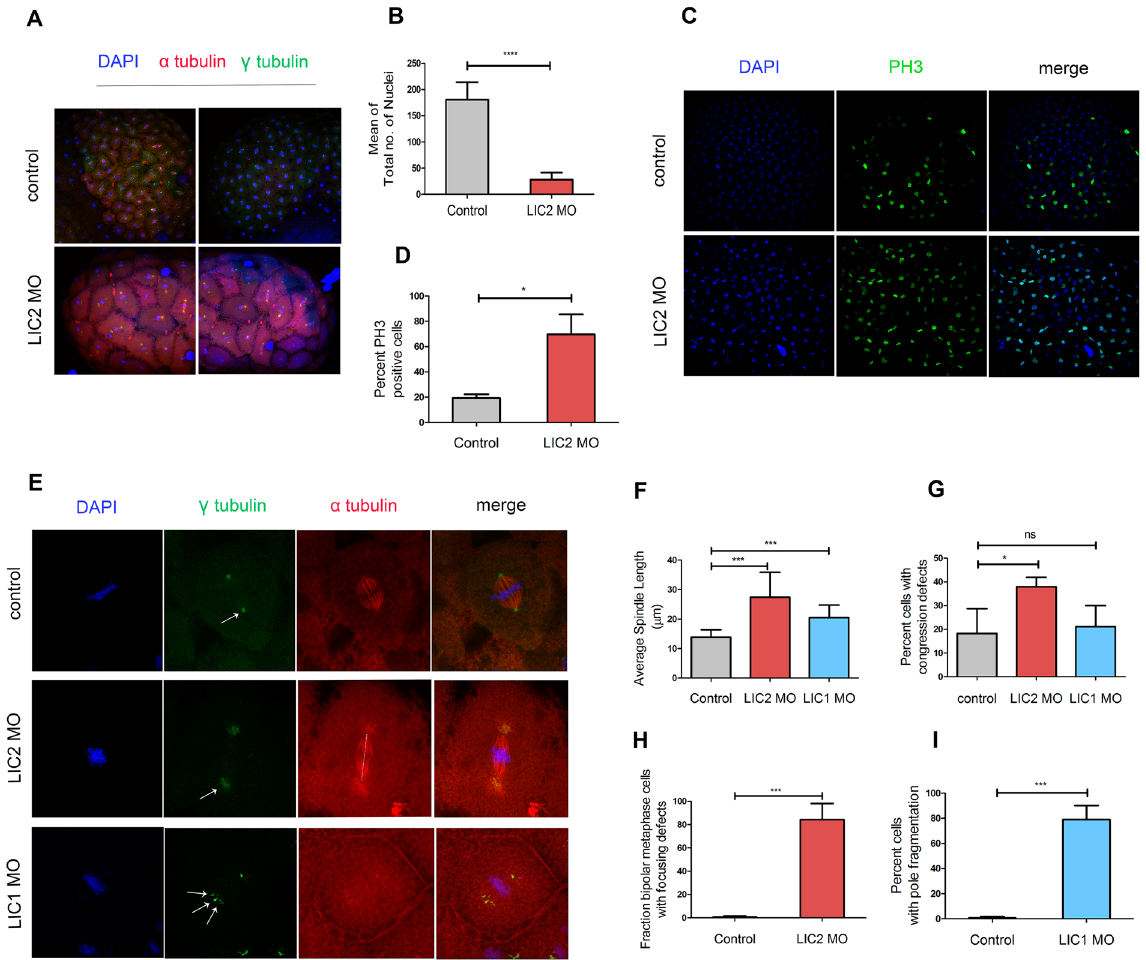
Figure 7. Zebrafish LIC2 depletion leads to mitotic defects in early embryonic divisions. ( A ) Cytology of blastomeres upon LIC2 depletion. Each representative image shows the top surface view of the embryo at 3.3 hpf, recreated from confocal z-stacks. Control = embryos injected with standard control MO. Embryos are stained for microtubules (red), centrosomes (green) and chromosomes (blue). ( B ) Total average number of nuclei per embryo in surface blastomeres of time-matched embryos (minimum 3 experiments, n = 10 control and 23 LIC2 depleted embryos). ( C ) Sum projections of confocal z stacks showing mitotic cells labelled with phosphohistone 3 (PH3, green) and chromatin (DAPI, blue). ( D ) Fraction of PH3 positive cells upon respective treatment. N = 23 and 15 embryos respectively for uninjected and LIC2 MO treatment from 2 experiments. ( E ) Confocal images of surface blastomeres showing longer mitotic spindles (white dotted line), control and unfocused spindle poles (white arrows) and fragmented spindle poles (multiple white arrows) in zLIC1 and zLIC2 morphants. Chromosomes (DAPI, blue), spindle poles ( γ -tubulin, green) and microtubules ( α -tubulin, red) are immunostained as indicated. ( F ) Average spindle length in surface blastomeres. n = 139 control cells (30 embryos), 118 metaphase cells for LIC2 depletion (26 embryos) and 52 metaphase cells (10 embryos) for LIC1 depletion, across a minimum 3 experiments each. ( G ) Fraction of blastomeres showing chromosome congression defects from the embryos in F. ( H ) Fraction of blastomeres showing spindle pole focusing defects upon LIC2 depletion. n = 69 control metaphase cells (12 embryos) and 95 metaphase cells (16 embryos) across a minimum of 3 experiments each. ( I ) Fraction of blastomeres showing spindle pole fragmentation upon LIC1 depletion. n = 52 metaphase cells (10 embryos) across 3 experiments. Error bars are mean + / −